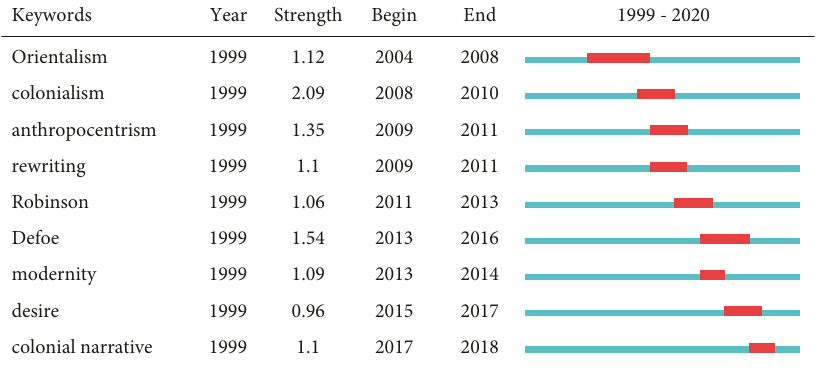
Figure 2: Top 9 keywords with the strongest citation bursts. Notes: the keywords with the most robust citation bursts (the bars mean some keywords cited). Table 8: Top 10 keywords by degree. degree